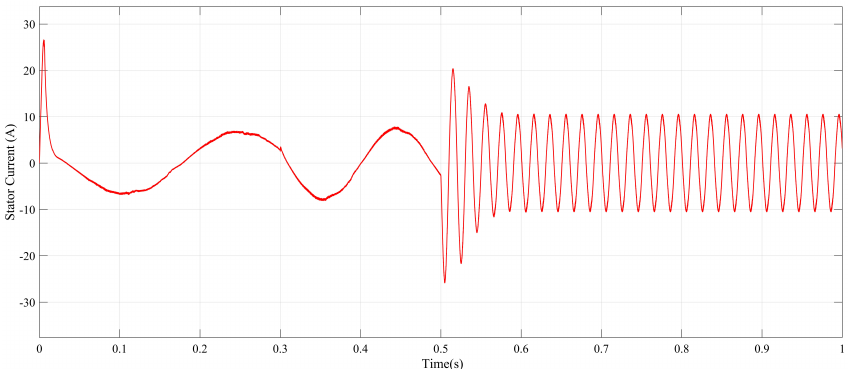
Figure 3. Stator current response to step change in speed reference and load torque.